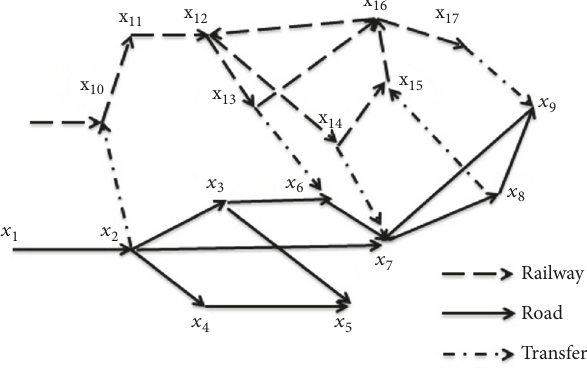
Figure 2: Multimodal transport